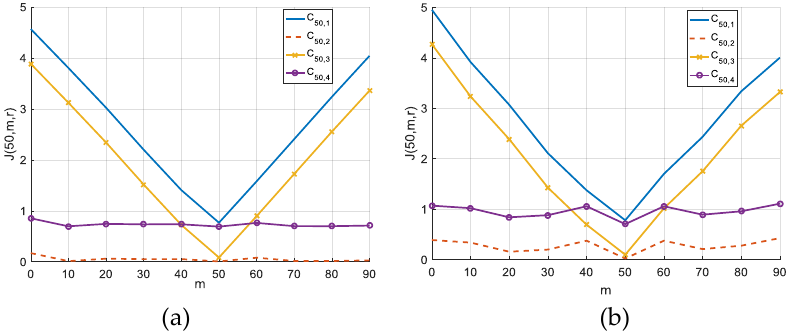
Figure 6. The model of the simulated target. (a) The point-scatterer model. (b) The scatterer trajectories.